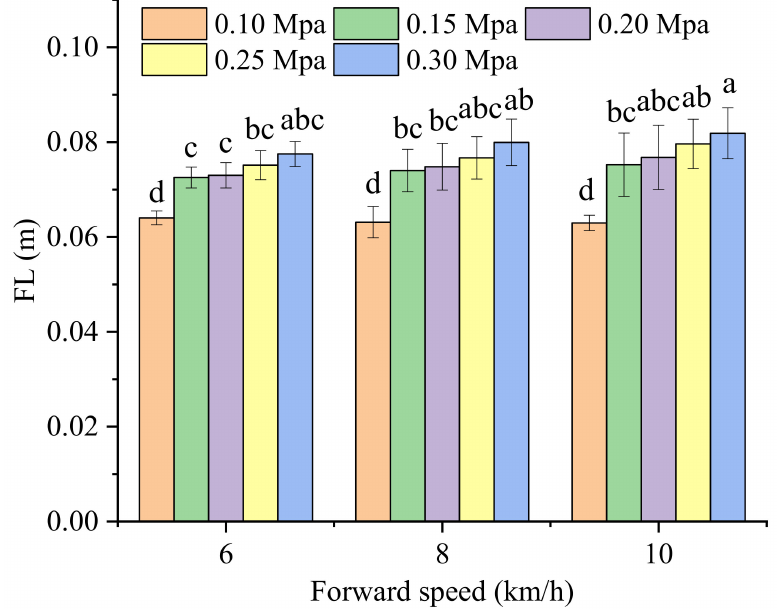
Figure 13. The length of the liquid starter fertilizer (FL) for different treatments. Only the values that are each denoted by different letter(s) ( a – d ) differ significantly at p <